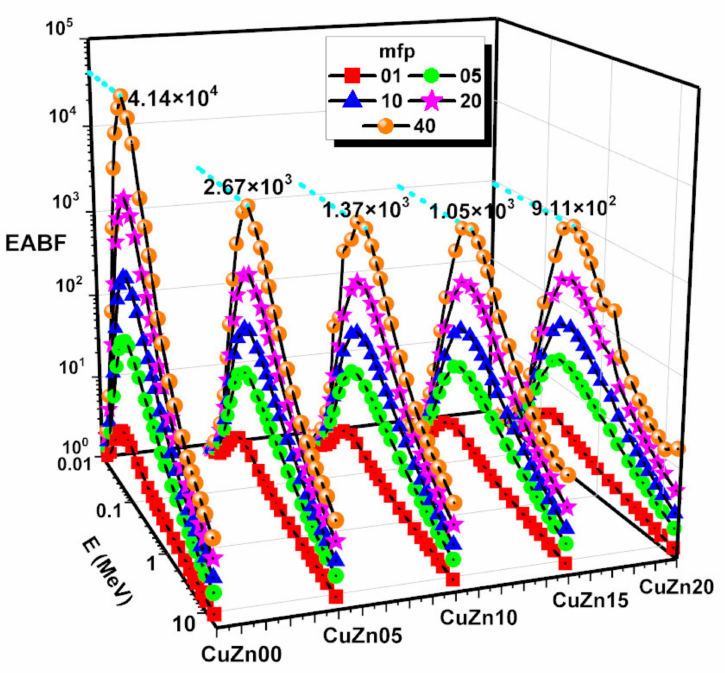
Figure 12. Energy absorption buildup factor (EABF) against photon energy of samples at 1, 5, 10, 20 and 40 mfp.